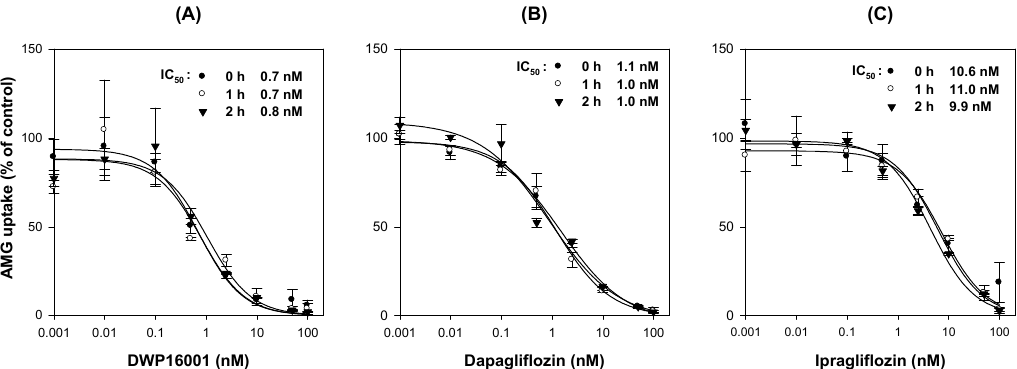
Figure 9. Inhibitory effect of ( A ) DWP16001, ( B ) dapagliflozin, and ( C ) ipragliflozin on the SGLT2-mediated uptake of 10 µM [ 14 C]methyl-a-D-glucopyranoside (AMG) was measured with preincubation time for 1 and 2 h or without preincubation of DWP16001, dapagliflozin, and ipragliflozin, respectively, in a concentration range of 0.001–100 nM. Each data point represents the mean ± standard deviation of three independent experiments.